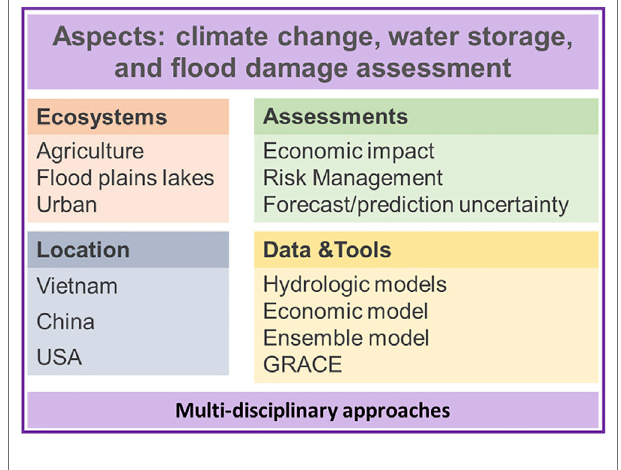
FIGURE 1 | Synthesis of